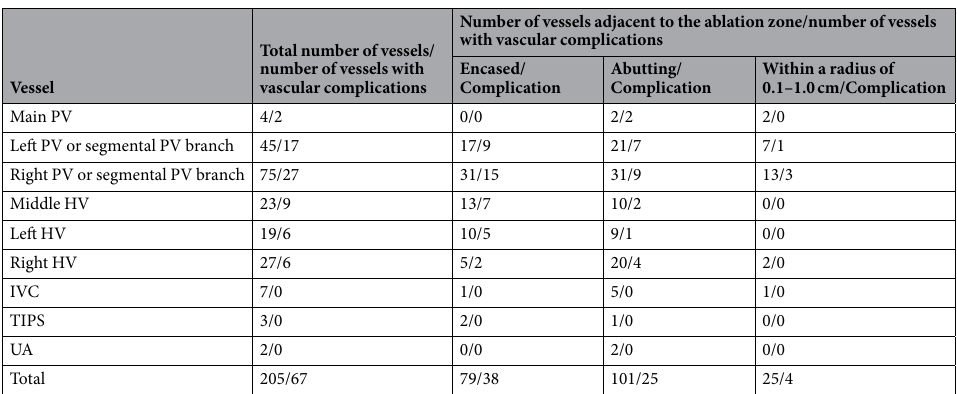
Table 3. Types and numbers of vessels adjacent to the ablation zone and numbers of vessels with vascular complications with regard to their localization. PV, portal vein; HV, hepatic vein; IVC, inferior vena cava; TIPS, transjugular intrahepatic portosystemic shunt; UA, umbilical